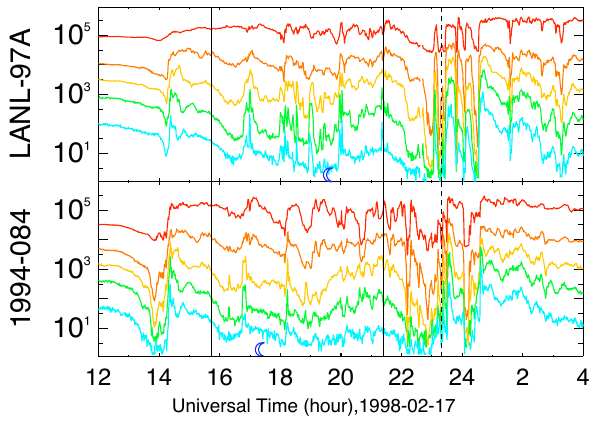
Fig. 9. LANL SOPA Proton data for Event 4. Each color is a different energy channel with red as the lowest energy and blue as the highest. The blue moon represents when the satellite is at local midnight and the red star is local noon. Once again, the solid black vertical lines represent the beginning and the ending of the BRI and the dotted line is the substorm at 23:19 UT.